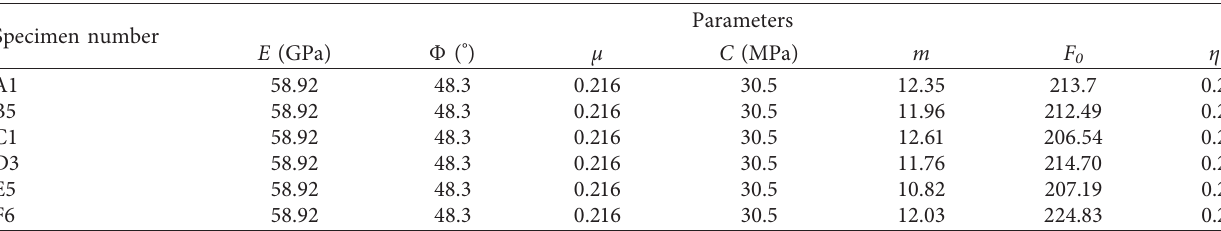
Figure 12: Uniaxial compressive strength and longitudinal wave velocity vs. impact frequency: (a) variation curve of uniaxial compressive strength and (b) variation curve of longitudinal wave velocity. Table 5: Experimental parameters and fitting